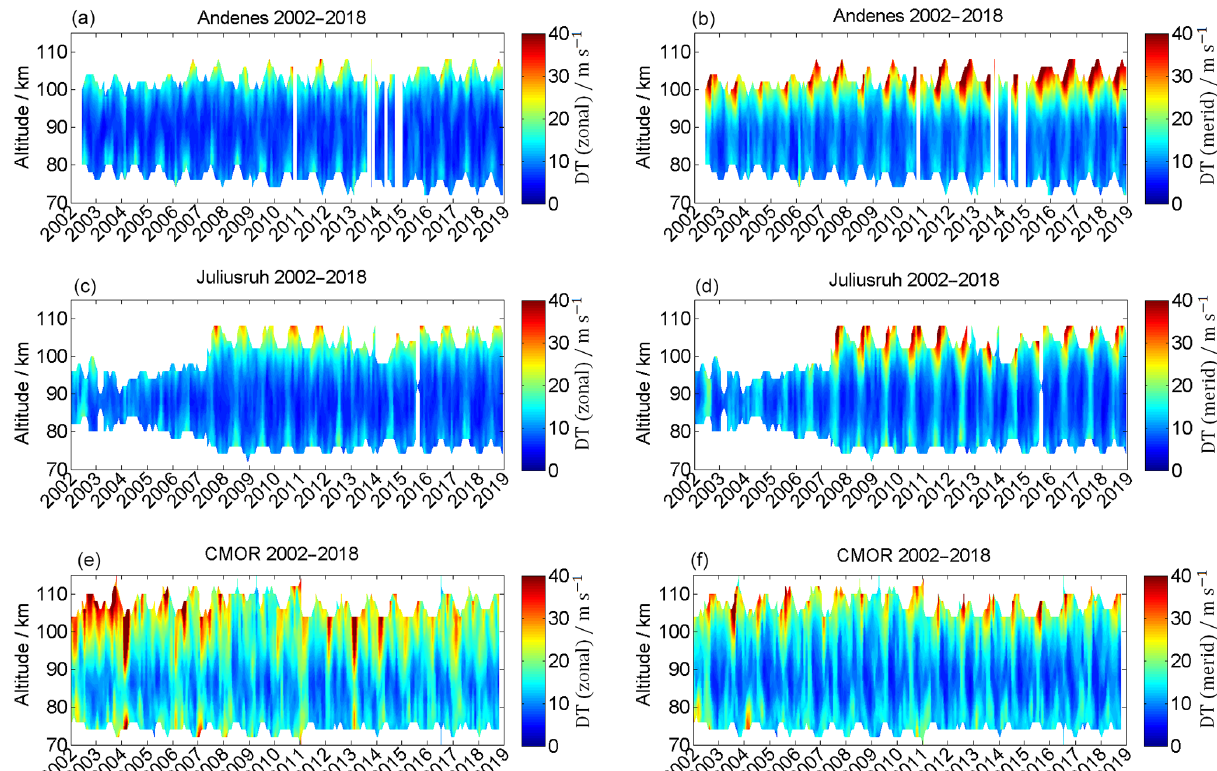
Figure 7. Time series of the zonal (a, c, e) and meridional (b, d, f) diurnal tidal components for Andenes (a, b) , Juliusruh (c, d) , and CMOR (e, f)